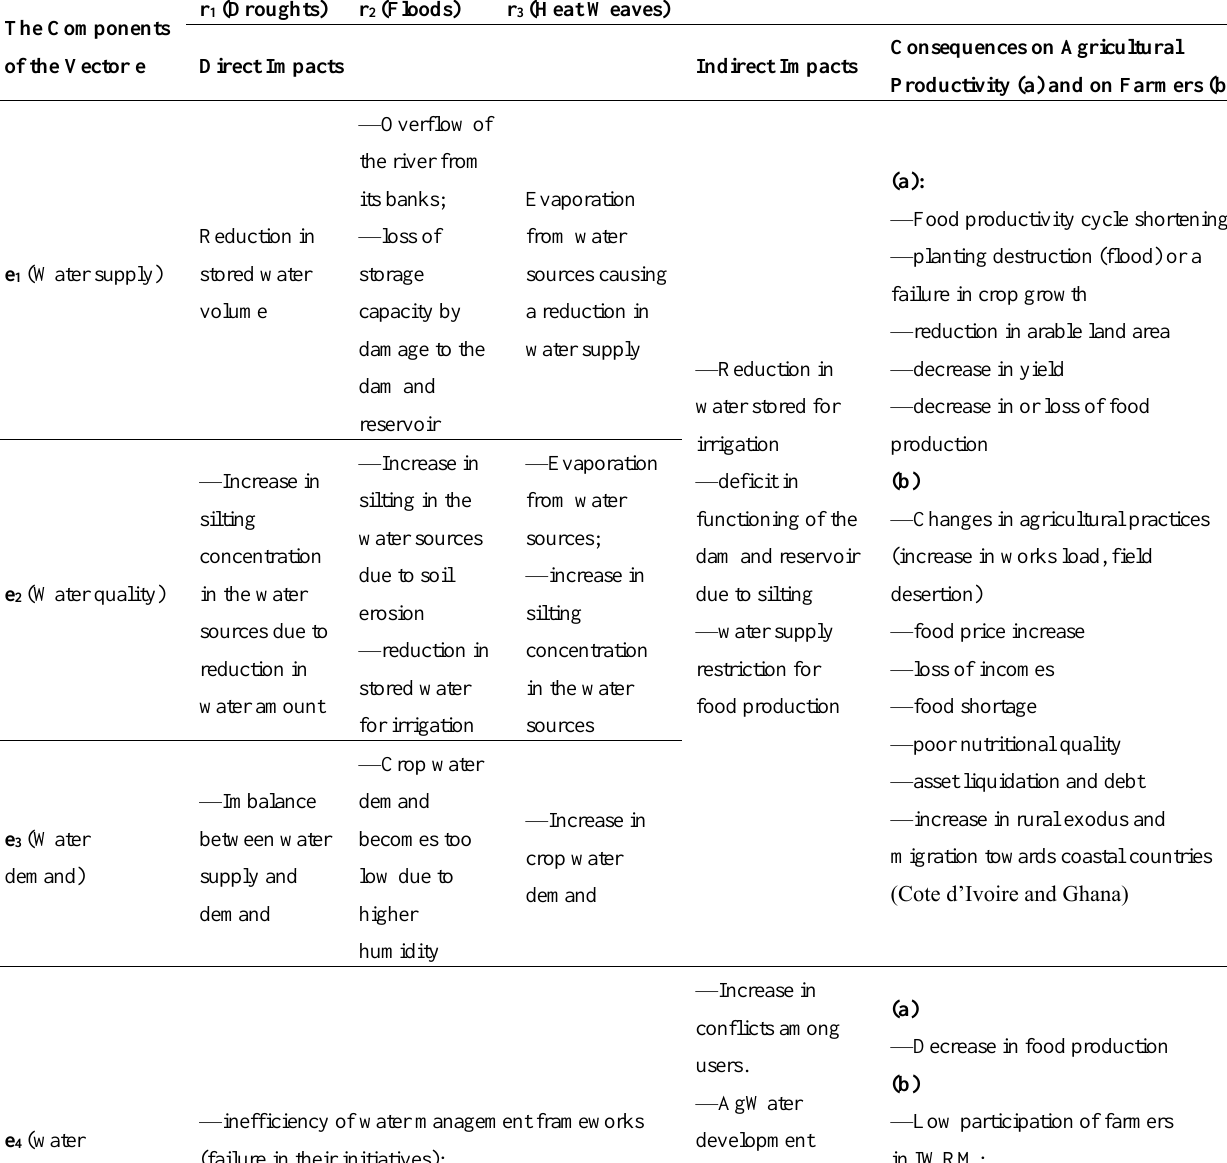
Table 2. Impacts of the climate risks vector (R) on the system vector